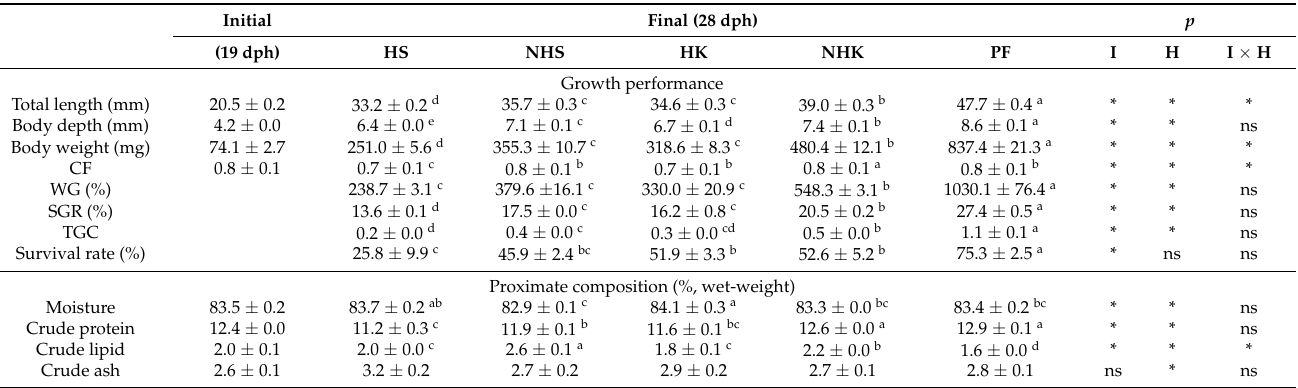
Table 6. Growth performance, proximate composition and biological indices of Pacific bluefin tuna fed the test diets 1 for 9 days.